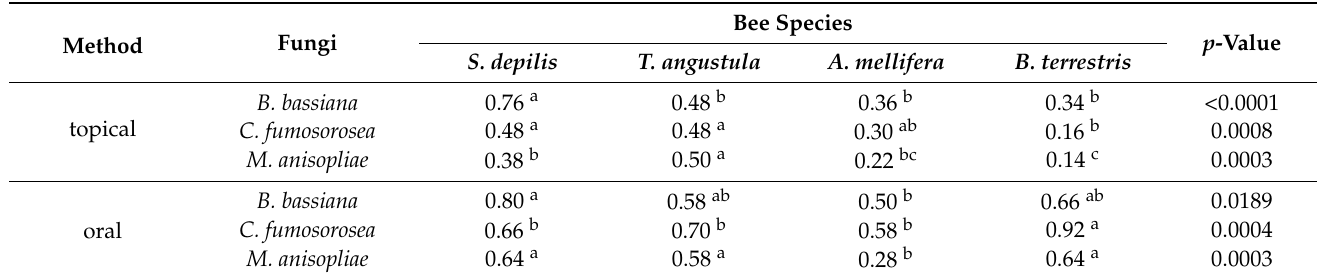
Table 1. Susceptibility of Scaptotrigona depilis, Tetragonisca angustula, Apis mellifera, and Bombus terrestris workers to the entomopathogenic fungi Beauveria bassiana, Cordyceps fumosorosea, and Metarhizium anisopliae for each exposure method (topical or oral). Mean mortality fitted to a generalized linear model (GLM) with binomial distribution, Tukey